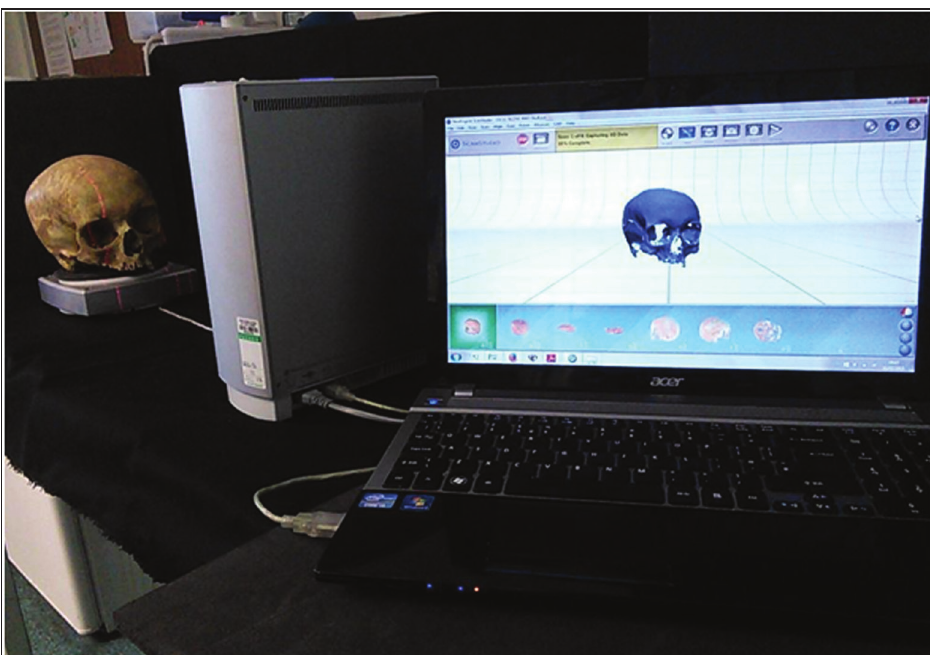
Figure 1: NextEngine laser scanner (model 2020i) in use at the Institute of Archaeology, collecting 3D data for a human skull. Photo: Sandra